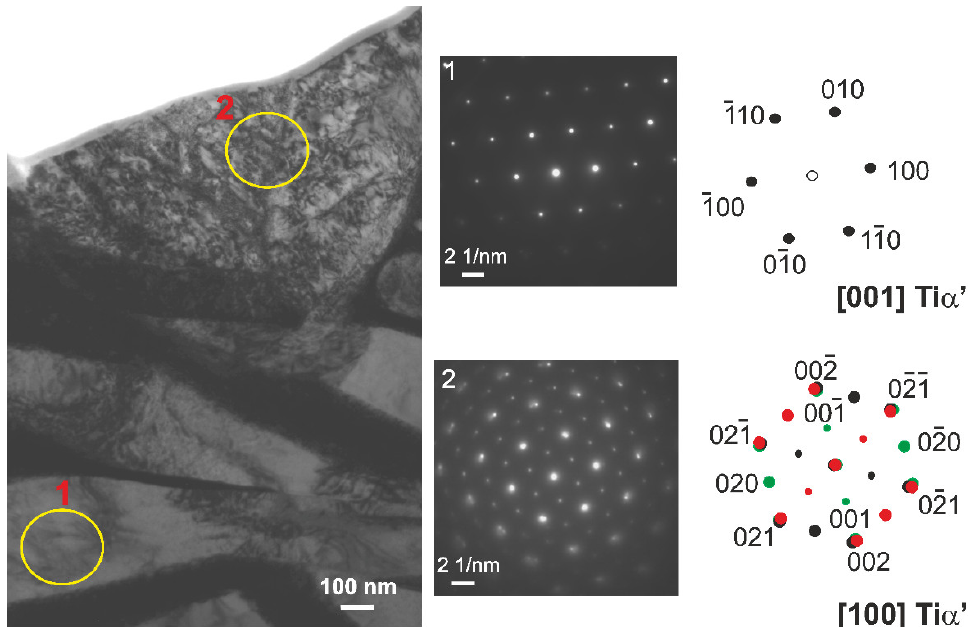
Figure 4. TEM image of the near-surface region in the Ti–13Nb–13Zr alloy after oxygen hardening at 700 °C. SAED patterns of α’ (hcp) and α’’ (orthorhombic, Cmcm) were taken from areas marked with 1 and 2, respectively. In the SAED pattern no. 2, the spots belonging to the three [100] α‘‘ zone axes are marked with black, green and red color. Indices of green spots are given.